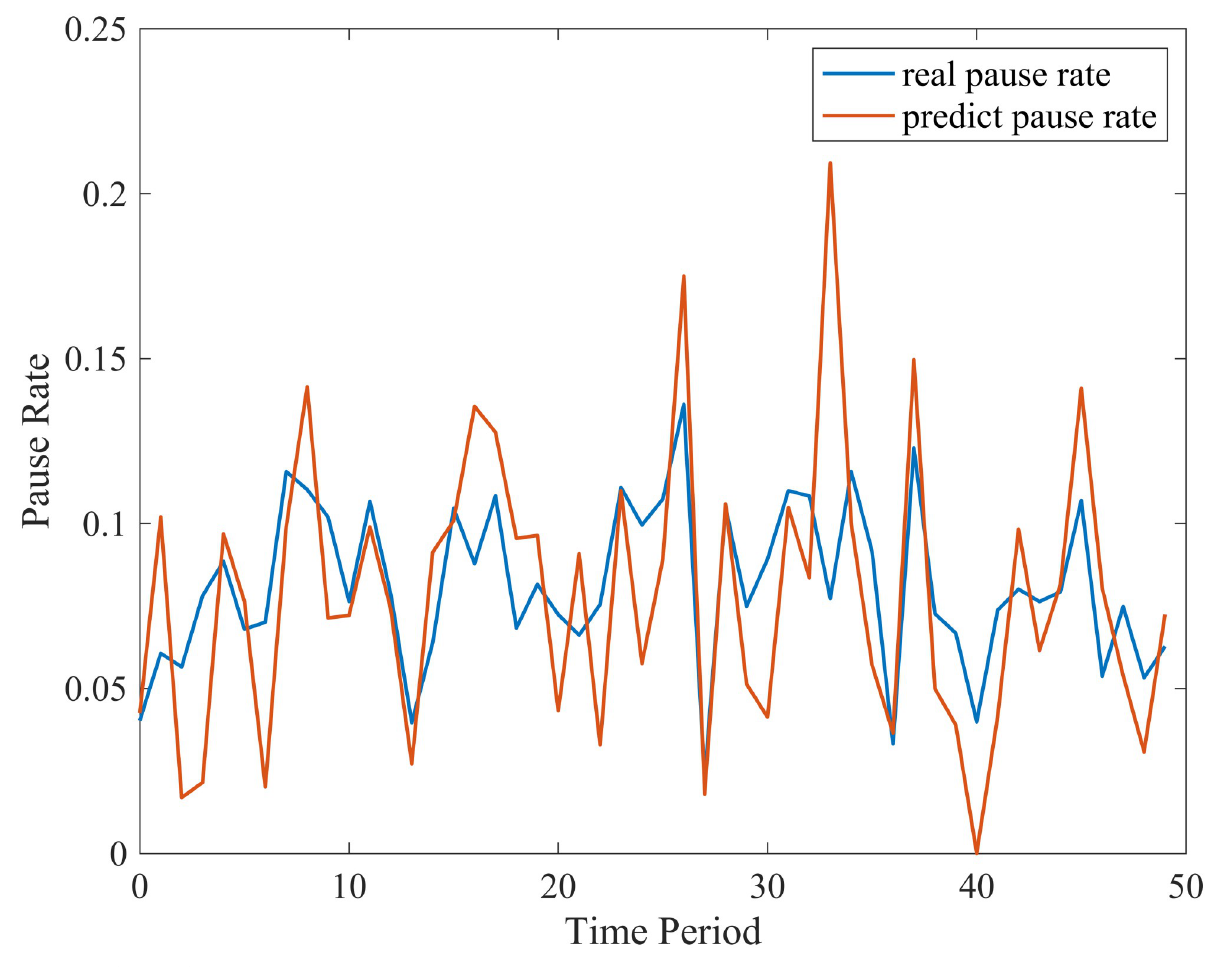
Fig 10. Prediction of pause